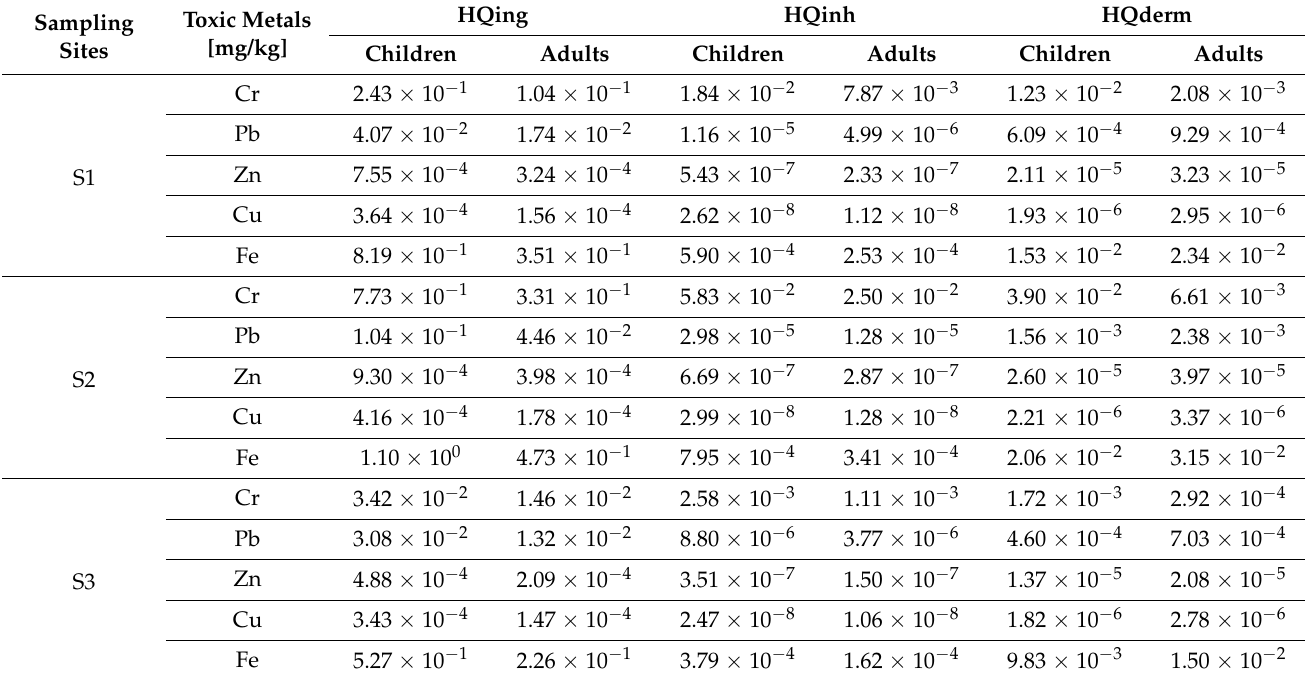
Table 9. HQ for ingestion, inhalation, and dermal contact for the sediments at all the studied sites: S1 “Bł˛ekitna Laguna”, S2 “Huta”, and S3 “Mała Szwecja” [mg/kg].